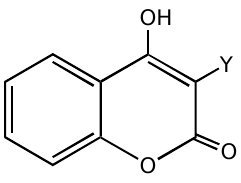
Figure 1. 4-Hydroxy-3-substituted coumarins.